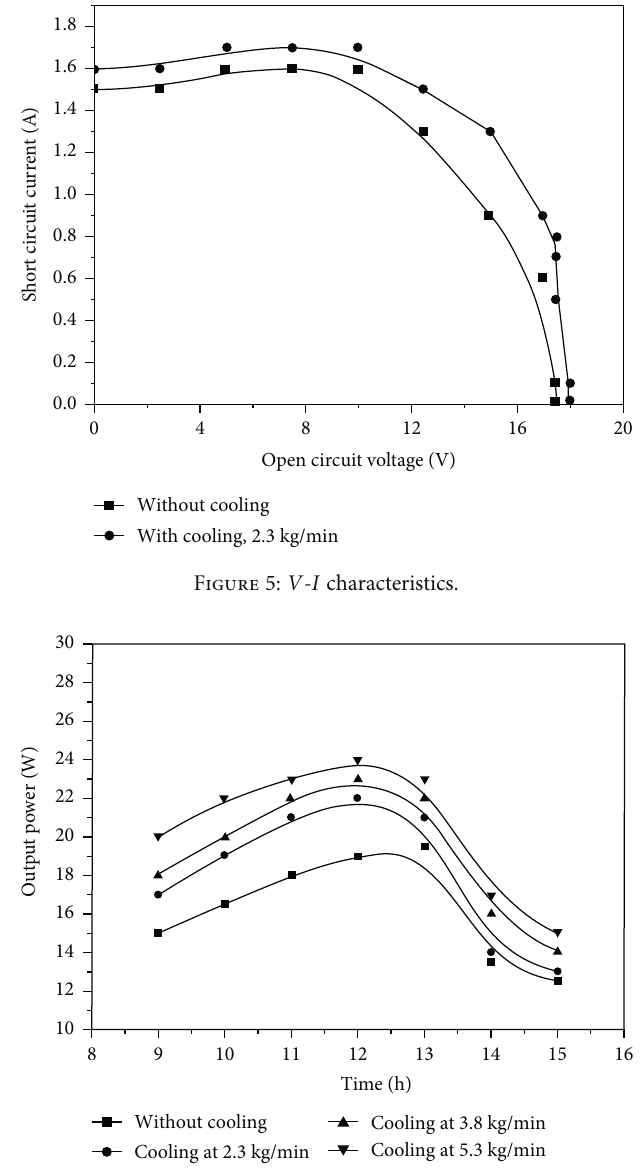
Figure 6: Output variation on cooling